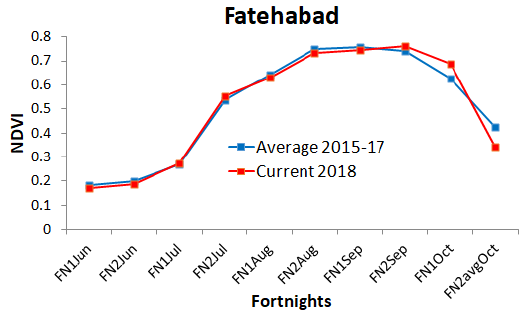
Figure 3. Rice growth pattern for estimation of harvesting pattern (from NDVI data) of Fatehabad district of Haryana, 2018 vis-à-vis average of 2015 to 2017